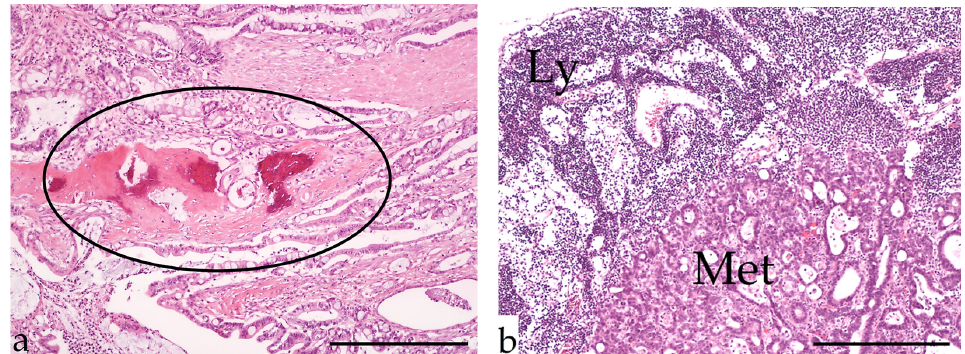
Figure 5. Intestinal carcinoma. ( a ) Osseous metaplasia (circle) in a tubular carcinoma of a 13-year-old male Chartreux; (HE stain, bar = 300 µm). ( b ): Metastasis of a tubular carcinoma (Met) in a regional lymph node (Ly) of a 16-year-old female spayed Persian; (HE stain, bar = 300 µm). Regardless of the dominating growth pattern, the neoplastic cells were irregularly cuboidal to columnar with a moderate amount of eosinophilic cytoplasm with varying degrees of vacuolisation and goblet cell differentiation. There was moderate to